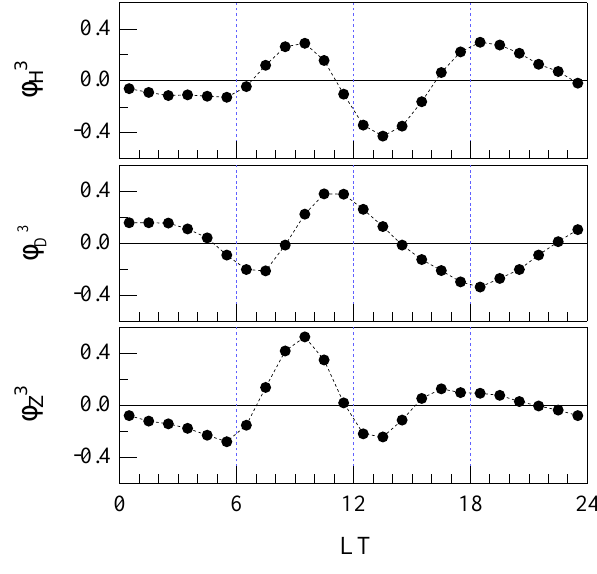
Fig. 8. The EOFs associated with the contribution to the daily vari- ation due to the magnetopause current system and relative to H, D and Z magnetic field